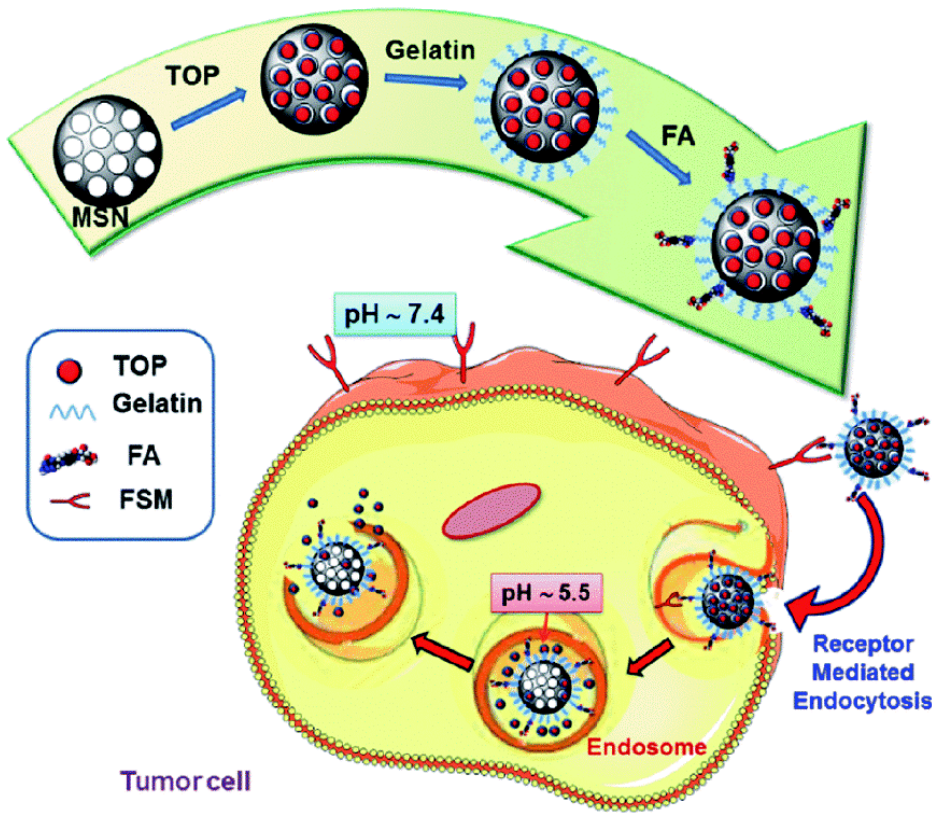
Figure 9. Schematic illustration of the tumor-targeted TOP nanosystem consisting of MSNs encapsulating TOP, coated with a gelatin shell and decorated with folic acid (FA) as targeting ligand. FSM stand for surface markers with affinity toward FA, which are usually overexpressed in the membrane of certain tumor cells. Reproduced with permission from ref. [155]. Copyright 2011, The Royal Society of Chemistry.